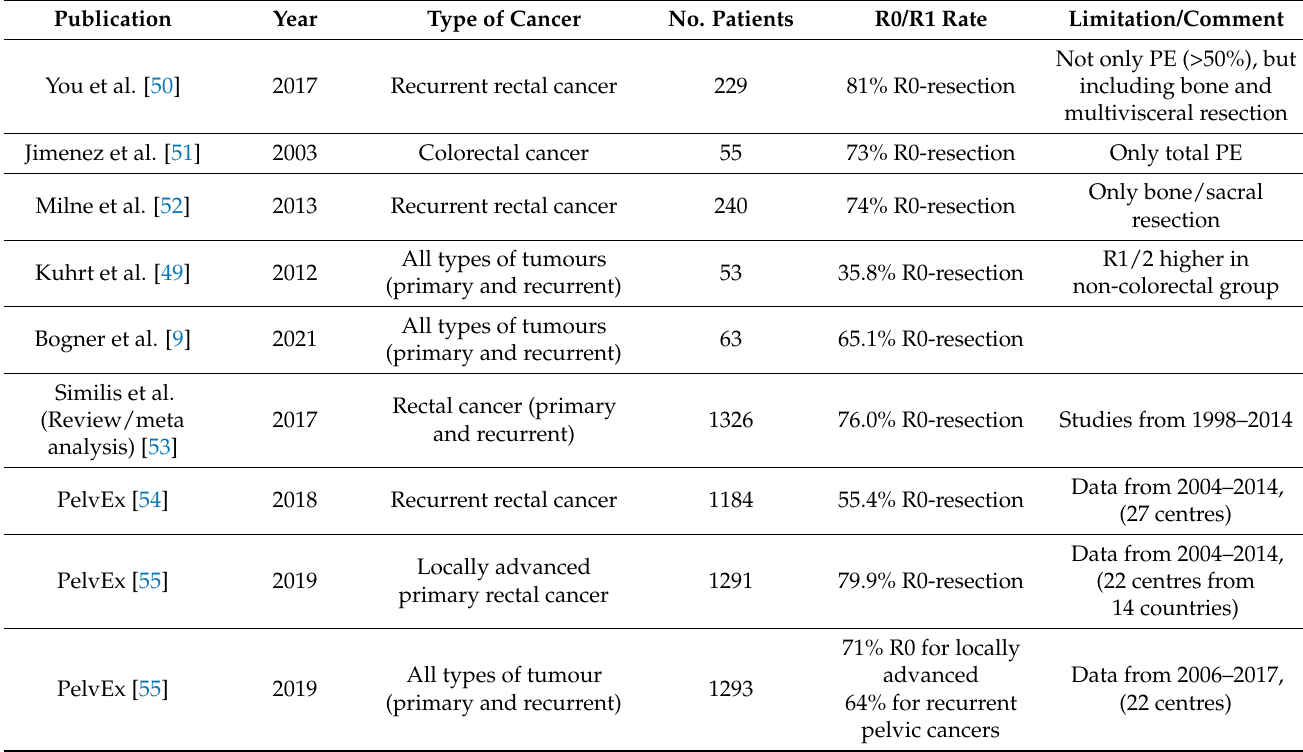
Table 3. Literature (selected database)-R0/R1 resection rates of pelvic